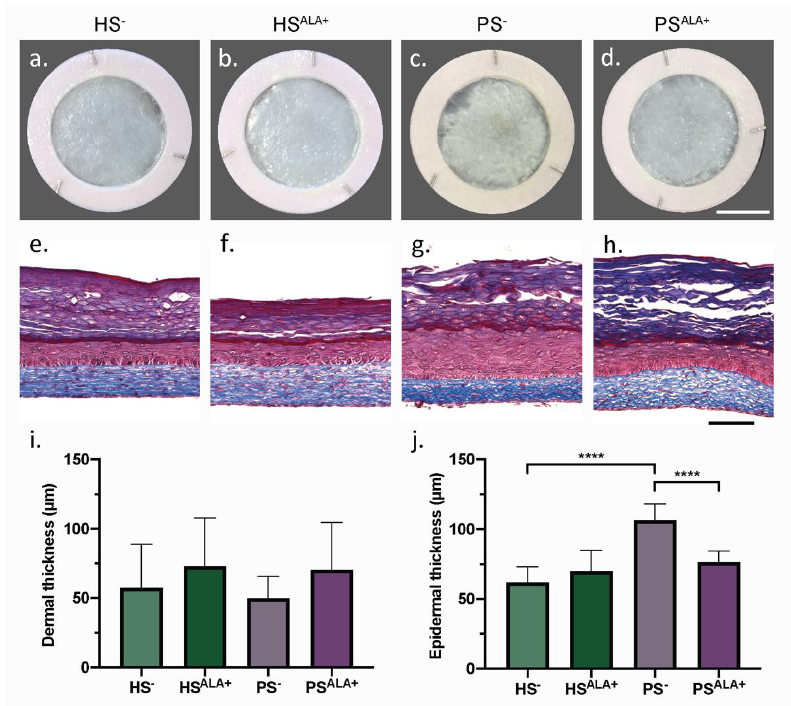
Figure 1. Biological activity of α -linolenic acid on skin substitute morphology. ( a – d ) Macroscopic appearance and ( e – h ) histological appearance after Masson’s trichrome staining of the skin substi- tutes. Scale bar: ( a – d ) 1 cm; ( e – h ) 100 µm. Thickness measurements of the dermis ( i ) and the epider- mis ( j ) (N = 3 donors, n = 2 skin substitutes per donor). ( i , j ) Statistical significance was determined Scale bar: ( a – d ) 1 cm; ( e – h ) 100 µ m. Thickness measurements of the dermis ( i ) and the epidermis ( j using one- way ANOVA followed by Tukey’s post -hoc test. **** p < 0.0001. Abbreviations: ALA —α - linolenic acid; HS — healthy substitute; PS — psoriatic substitute.